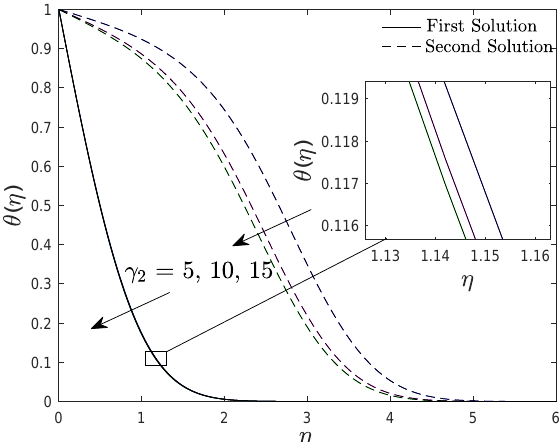
Figure 6. Nanofluid temperature in a limiting range of γ 2 with λ = − 1,1.